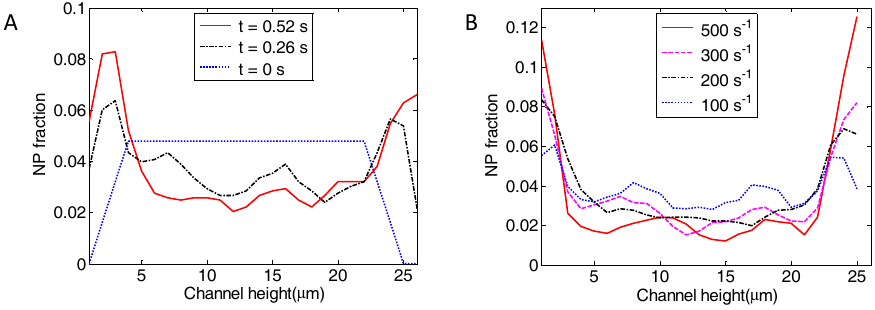
Figure 6. The NP fraction across the channel height for a hematocrit level of 23.5%. ( A ) NP fraction at t = 0, 0.26 s and 0.52 s for a shear rate of 200 s − 1 ; and ( B ) NP fraction at t = 0.52 s for shear rates of 100 s − 1 , 200 s − 1 , 300 s − 1 and 500 s − 1 .